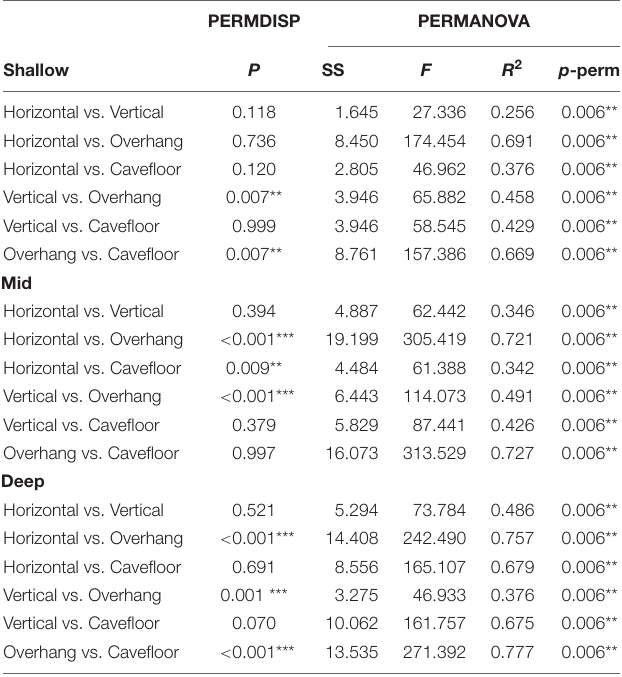
TABLE 2 | Multivariate tests used to detect differences between surface orientations among